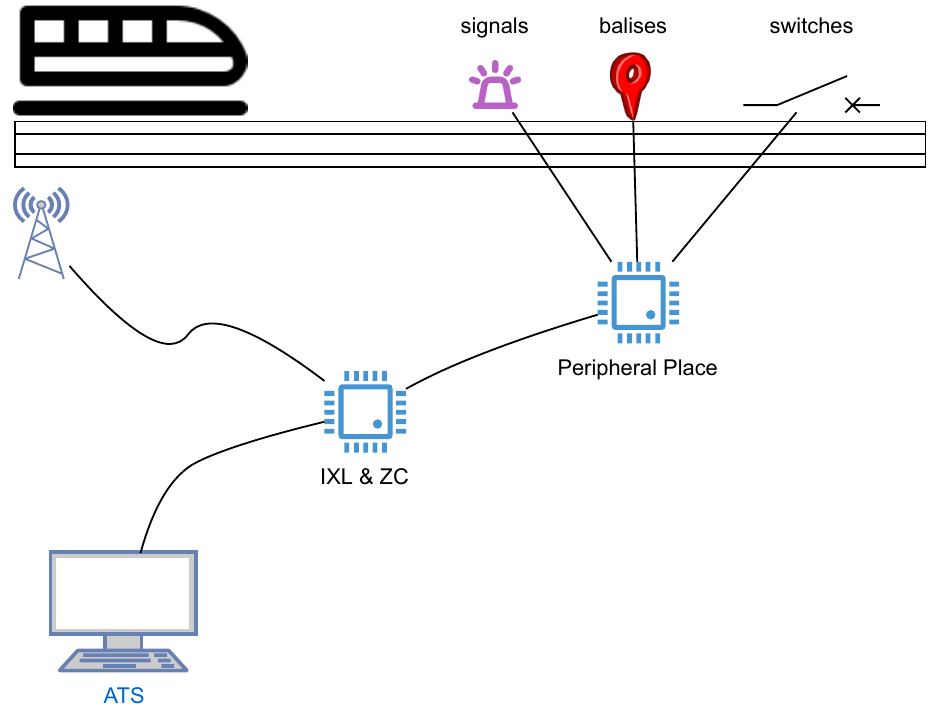
Figure 12. Overview of